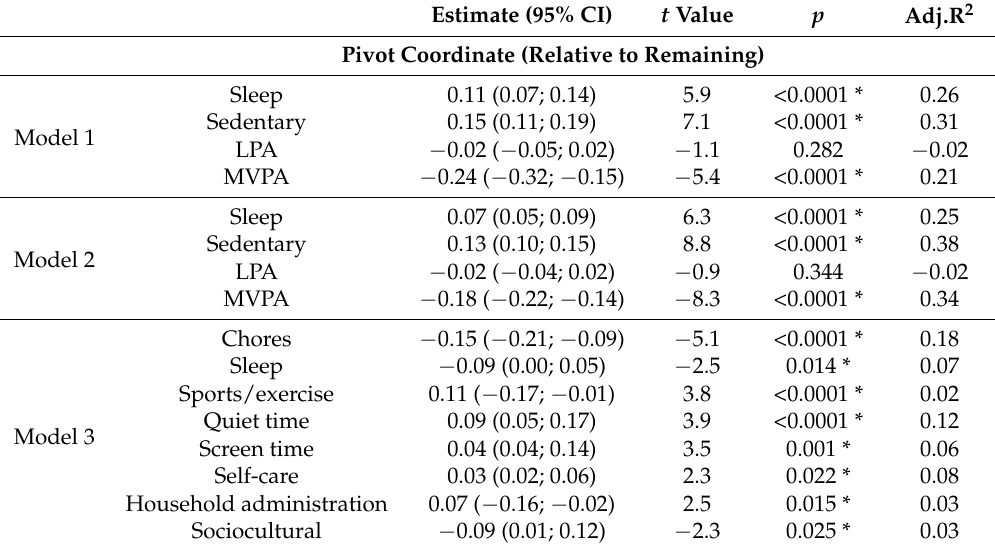
Table 3. The relationship between the BODE index and relative time in energy-expenditure band (Model 1 & 2) and time-use components (Model